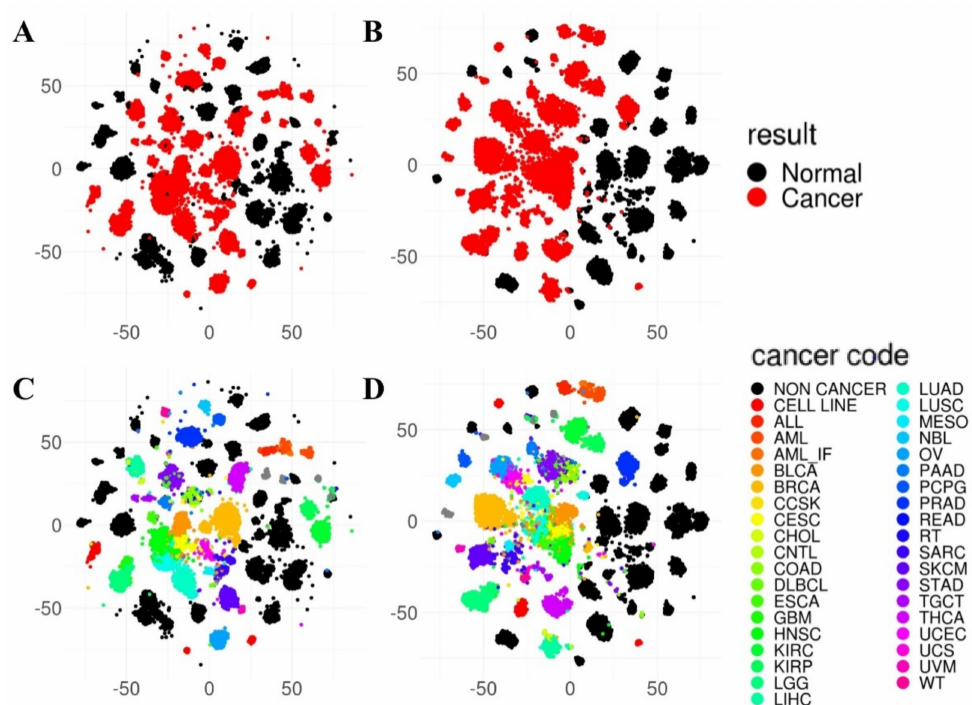
Figure 2. t-SNE analysis of pathway index and pathway member gene expression. ( A ) Pathway member gene expression represents both cancer and normal tissue-related information. ( B ) The pathway index also includes cancer and normal tissue-related information (e.g., pathway member gene expression data). ( C ) Pathway member gene expression contains information on cancer types. ( D ) The pathway index also contains information on cancer types, such as pathway member gene expression.